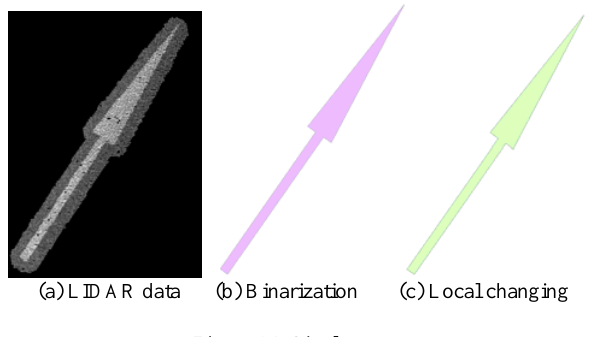
Figure 14. Single arrow Stop : This traffic marking is built from